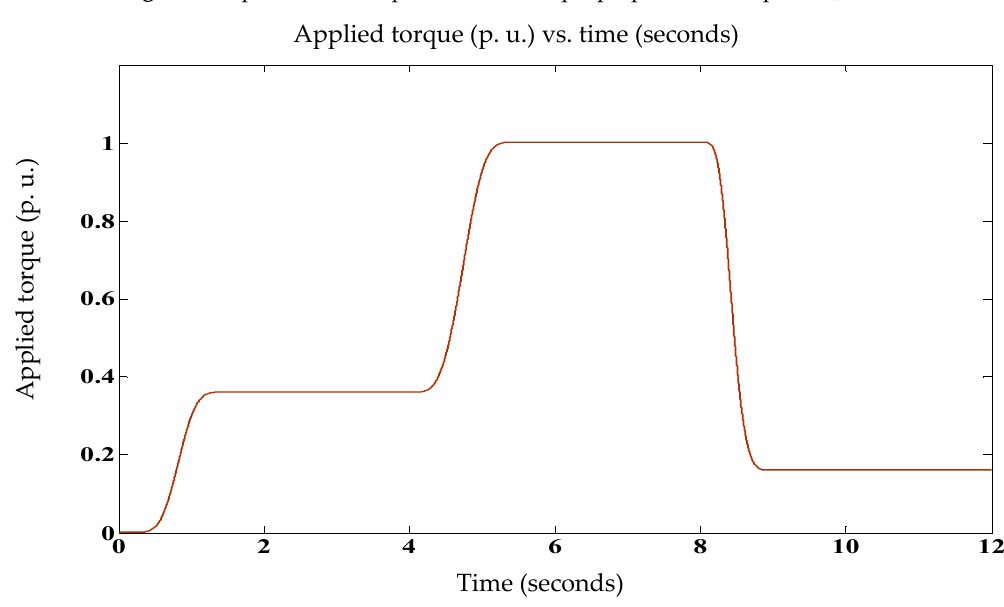
Figure 14. Applied torque: T L α ω 2.